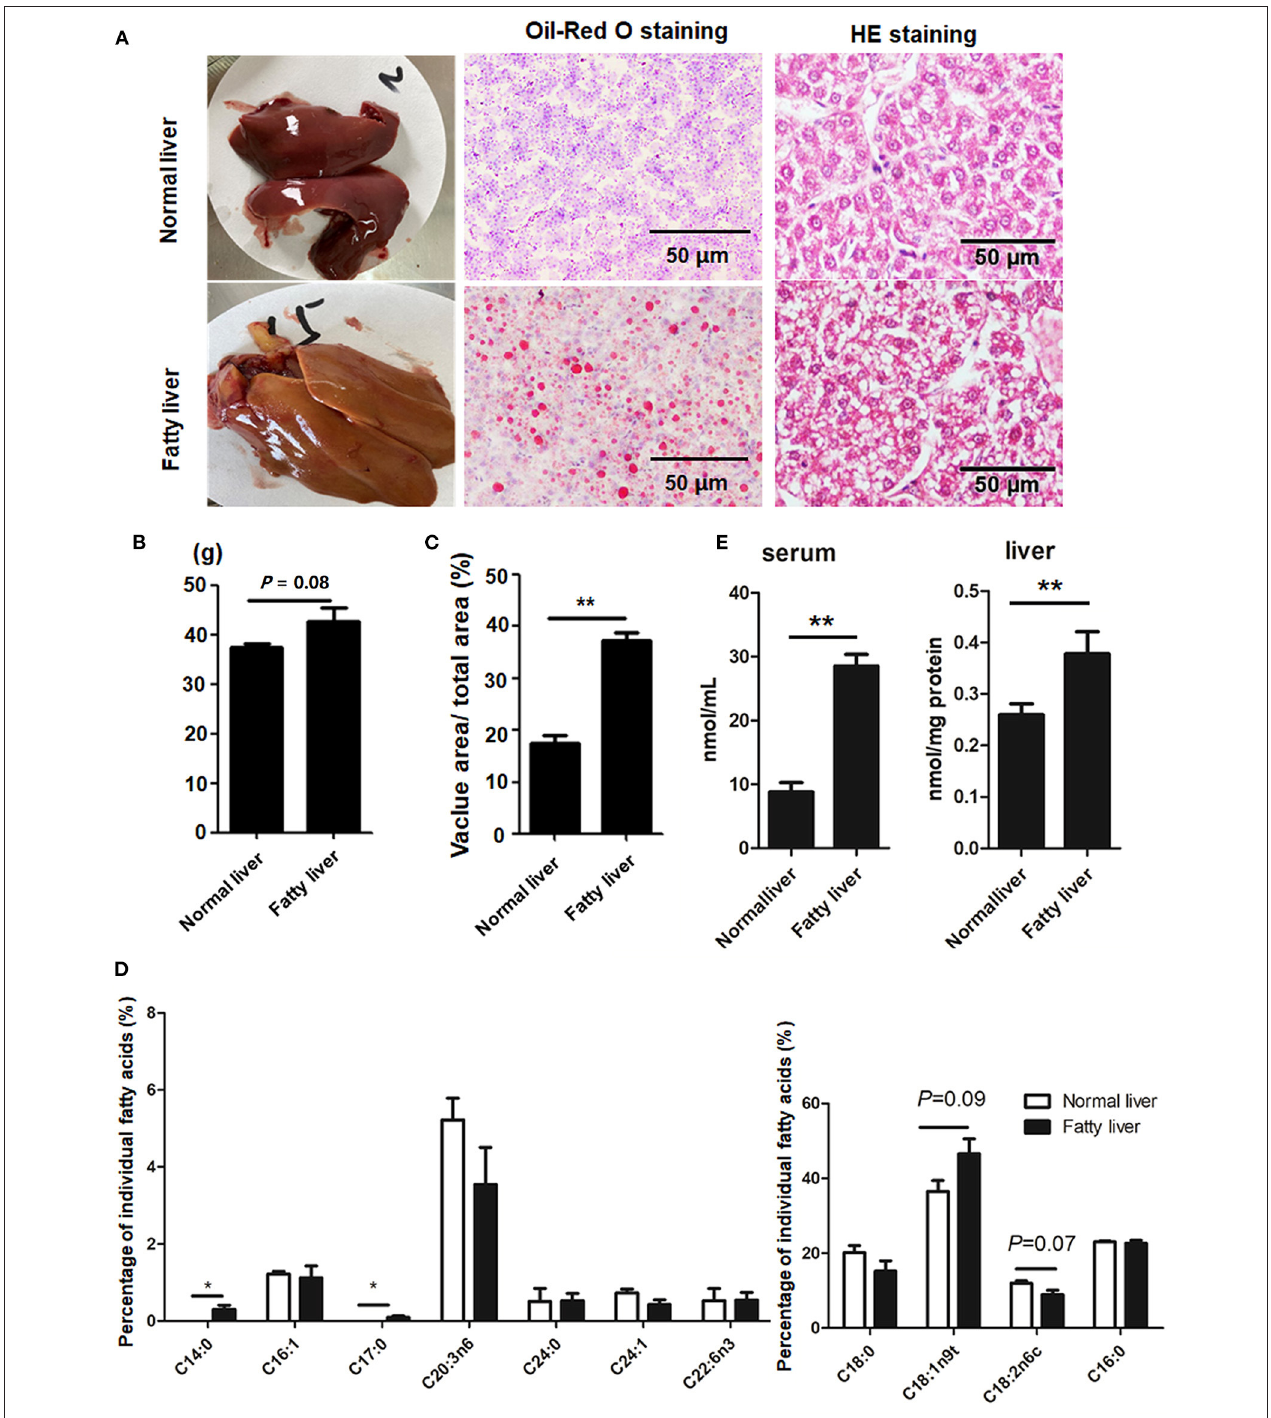
FIGURE 1 | Hepatic lipid accumulation in chicken fatty liver (A) Representative images of H&E staining and Oil-Red O staining (200 × magnification). (B) Weight of normal and fatty livers ( n = 15). (C) Quantification results of fat vacuoles within the section. (D) FA composition between normal and fatty livers. Three to five individual livers were pooled for four biological replicates. The percentage of individual FAs was calculated according to the peak areas relative to the total area (total FAs were set at 100%). (E) Serum and Liver TG concentrations. * P < 0.05 and ** P < 0.01.